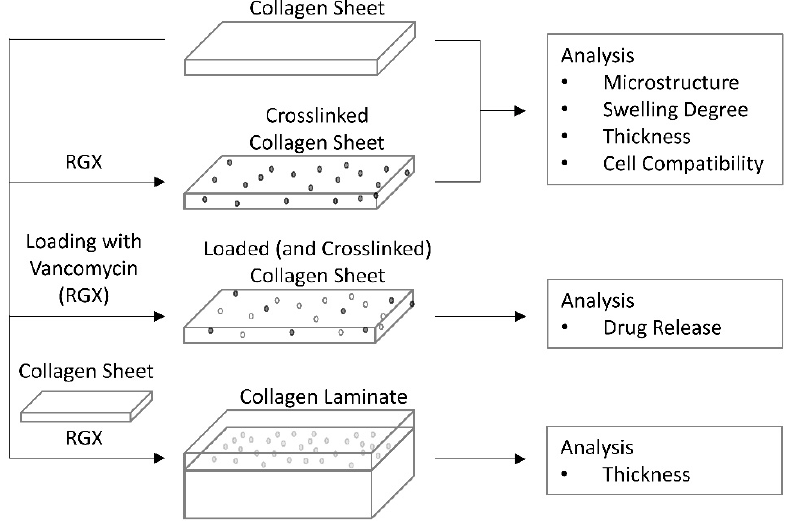
Figure 1. Overview of methods used for collagen analysis.